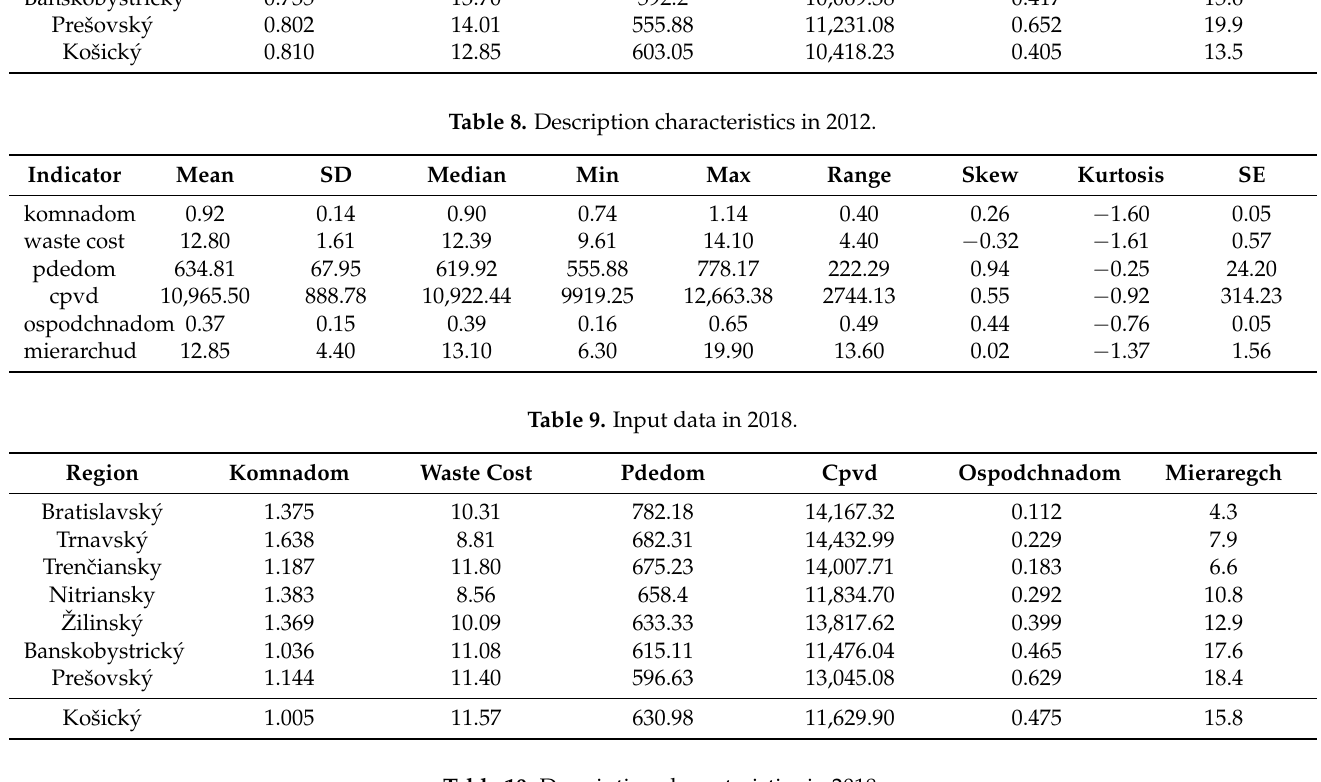
Table 10. Description characteristics in